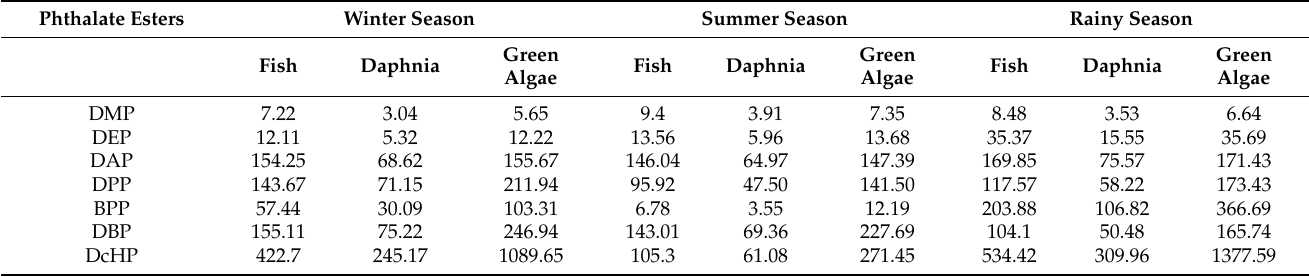
Table 4. Aquatic risk assessment of phthalate esters in water for fish; daphnia and green